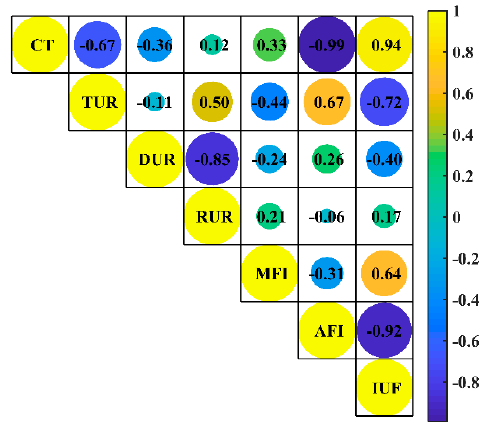
Figure 4. Principle of the improved construction simulation of high rockfill dam (CSHRD).